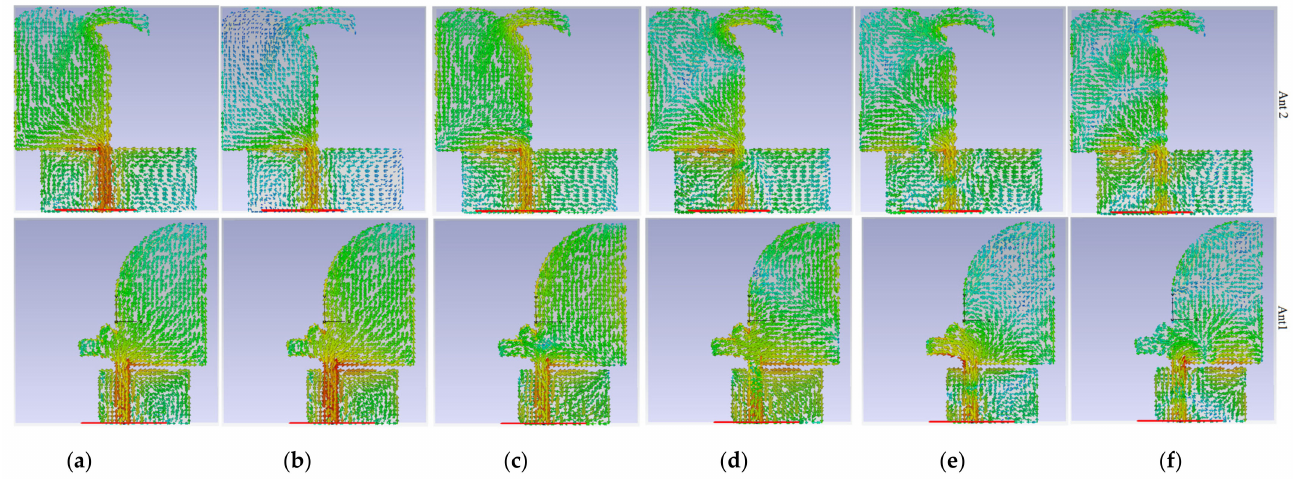
Figure 2. The SCD for Ant 1 and Ant 2 separately, before they were combined: ( a ) 3.8 GHz, ( b ) 5.2 GHz; ( c ) 8 GHz, ( d ) 15 GHz, ( e ) 22 GHz, and ( f ) 28